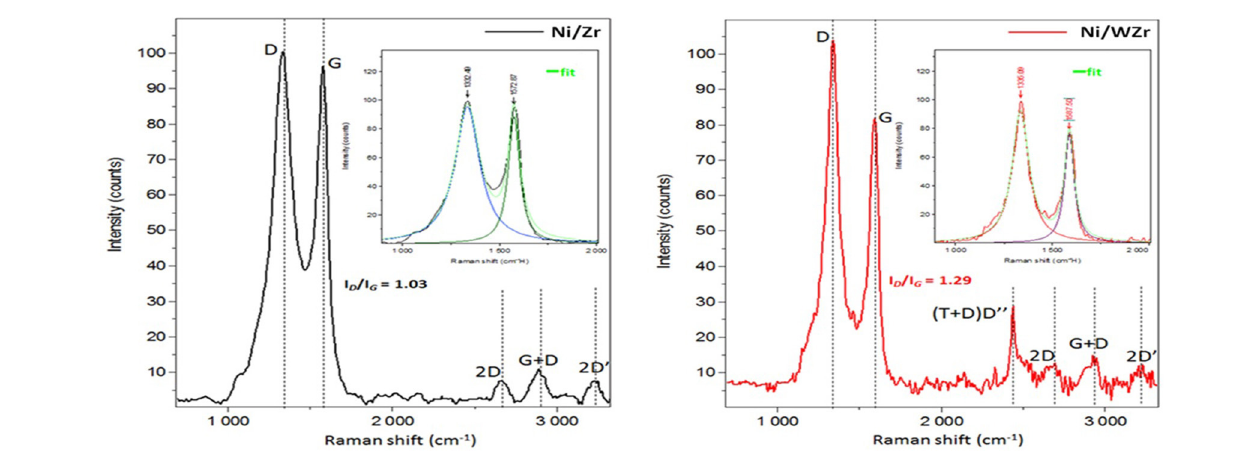
FIGURE 7 | Raman spectra of spend catalysts after the deconvolution process to yield Lorentzian D-peak, G-peak and D’ peak (inset, the first order region of the spectra).